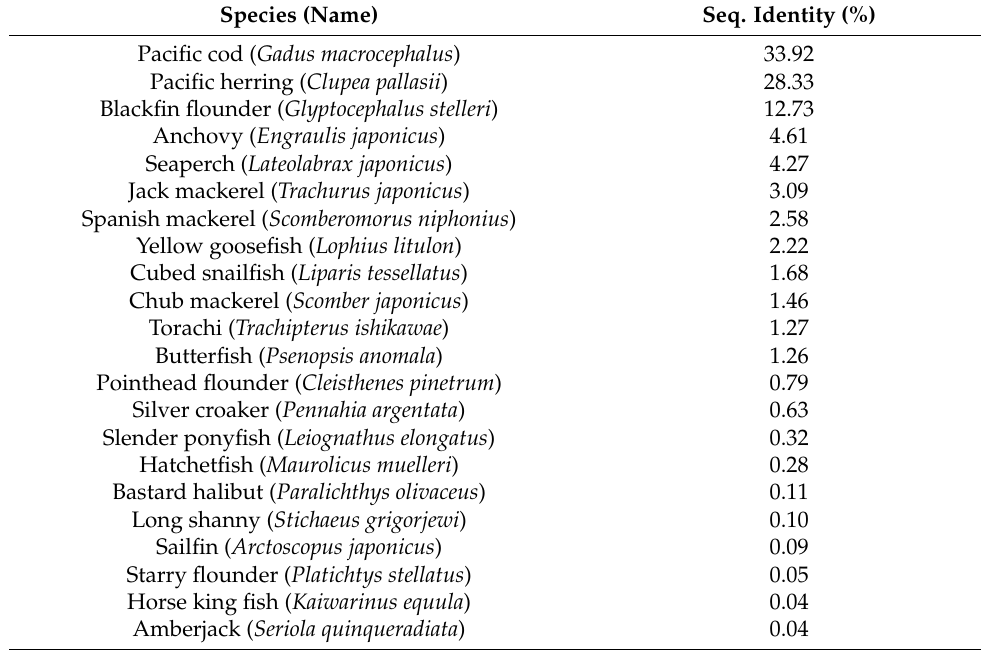
Table 2. List of fish species for